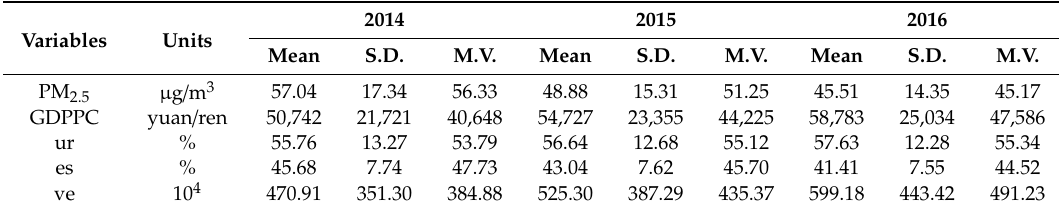
Table 1. Descriptive statistics of parts of variables.